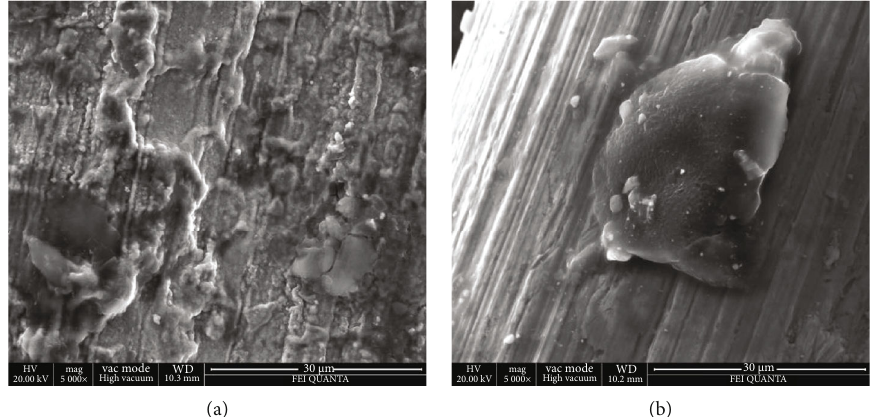
Figure 7: Surface morphology of heater surface: (a) 0.1% volume concentration Al